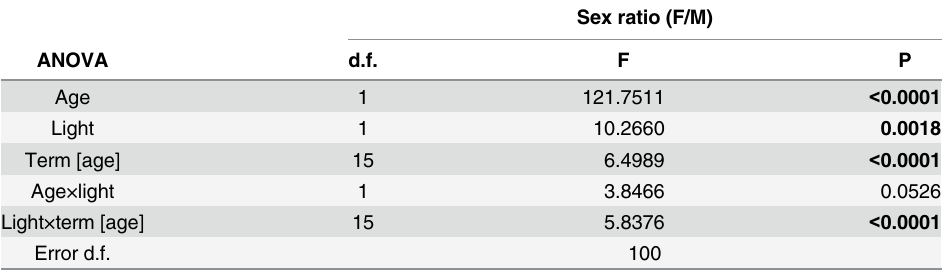
Table 4. Summary of ANOVA on the effects of time of occurrence (age: current-year vs 1-year-old), light conditions (high light vs shade), term (length of the sampling period, see Materials and Methods) and their interactions on the F/M sex ratio of adult Altica brevicollis coryletorum beetles. The factor “ term ” was nested in the factor “ age ” (term[age]). P values < 0.05 are in